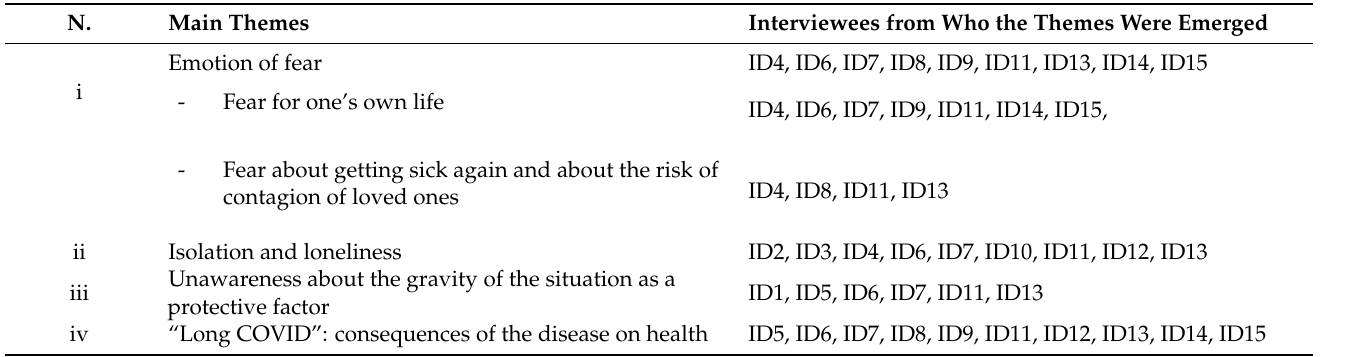
Table 3. Main themes emerged from the